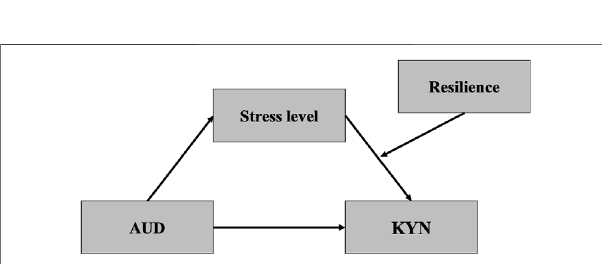
FIGURE 2 | The moderated mediation model in the present study. AUD, Alcohol Use Disorder; KYN, Kynurenine.